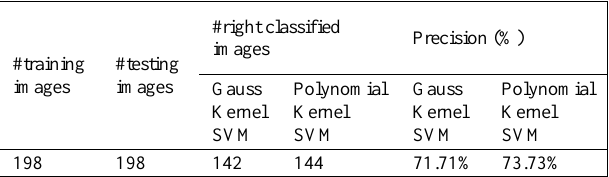
Fig. 20. One-class SVM vs.